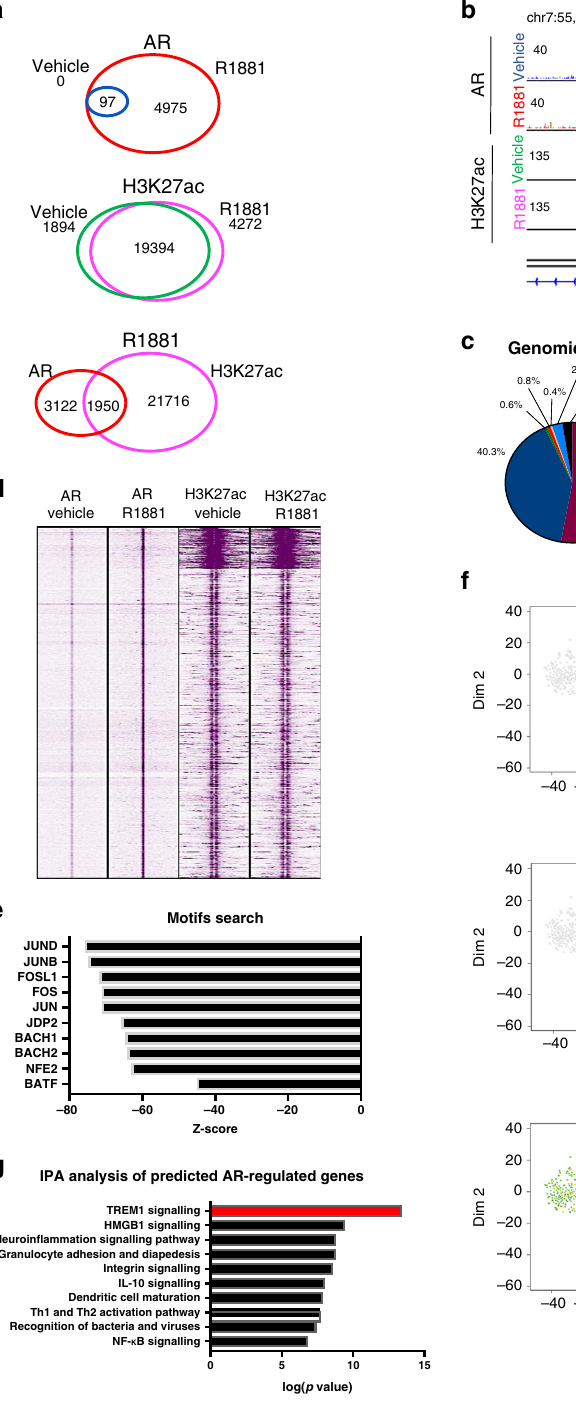
Fig. 5 ChIP-seq analysis shows distinct AR-binding pro fi les in THP-1 cells. a Venn diagrams showing the level of overlap between AR peaks in vehicle and R1881 conditions (upper panel), the overlap between H3K27ac peaks in vehicle and R1881 conditions (middle panel) and the overlap between AR and H3K27ac peaks in R1881 conditions (lower panel) in THP-1 PMA;IFNG;LPS cells. b Snapshot of AR and H3K27ac peaks in THP-1 PMA;IFNG;LPS cells. Genomic coordinates, gene name and tag counts are indicated. AR peaks in vehicle and R1881 conditions are depicted in blue and red, respectively. H3K27ac peaks in vehicle and R1881 conditions are depicted in green and purple, respectively. Range of normalized read counts is shown on the y axis. c Genomic distribution of AR-binding sites relative to the most proximal gene in THP-1 PMA;IFNG;LPS cells. d Clustered heatmap depicts all the AR-binding sites in THP- 1 PMA;IFNG;LPS cells vertically aligned, within a 5 kb window. H3K27ac peaks are shown for the same genomic locations. e Motif analysis of AR-binding sites in THP-1 PMA;IFNG;LPS cells identi fi es members of the AP-1 complex, including FOS and JUN. Z-score of enrichment is shown on the x axis. f RNA expression of AR transcriptional activators in single CD14 + and/or CD11b + cells isolated from PCa biopsies. In the tSNE plot, every dot represents a single cell. g Ingenuity pathway analysis of genes most proximal to AR-binding sites in THP-1 PMA;IFNG;LPS cells identi fi es TREM-1 as the most-enriched signalling pathway (indicated in